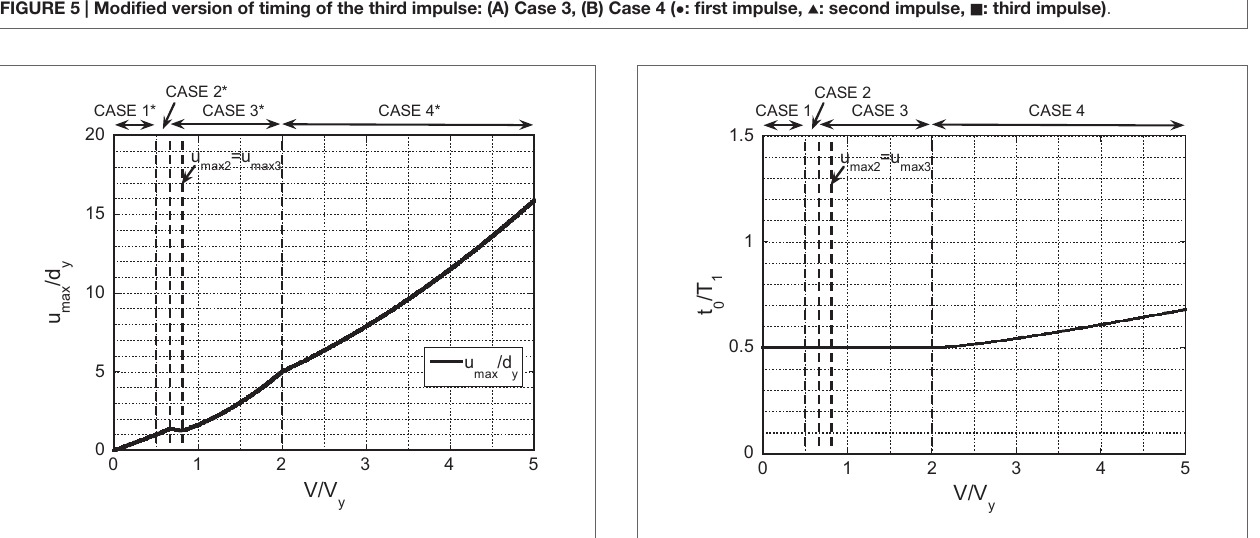
FigUre 6 | Maximum normalized elastic–plastic deformation under triple impulse with respect to input level (timing of the third impulse: zero restoring force) .